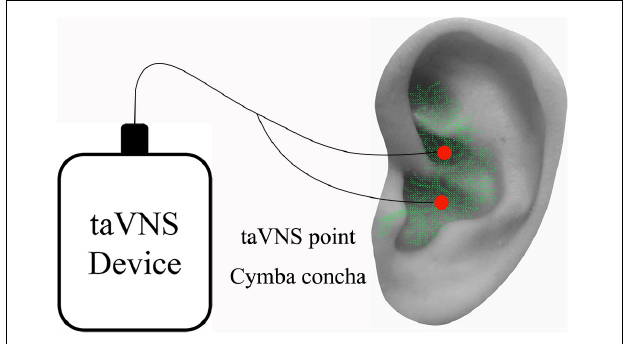
FIGURE 1 | taVNS stimulation site on the left ear. Red dots indicate regions of taVNS (ABVN, green color). ABVN , auricular branch of the vagus nerve; taVNS , transcutaneous auricular vagus nerve